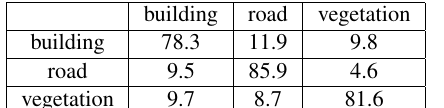
Table 2: Pixelwise accuracy of the MSMSH-CRF classification on the Beijing Airborne Data. The confusion matrix shows clas- sification accuracy for each class (rows) and is row-normalized to sum to 100%. Row labels indicate the true class, and column labels indicate the predicted class.